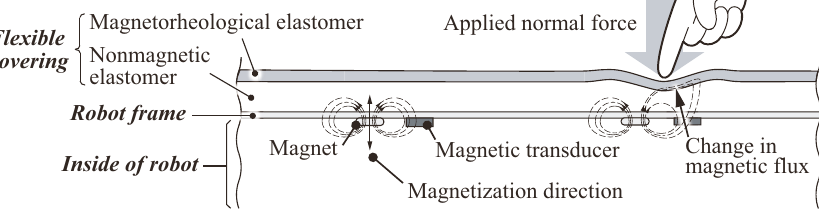
Figure 3. Schematic of the structure and sensing mechanism of the proposed